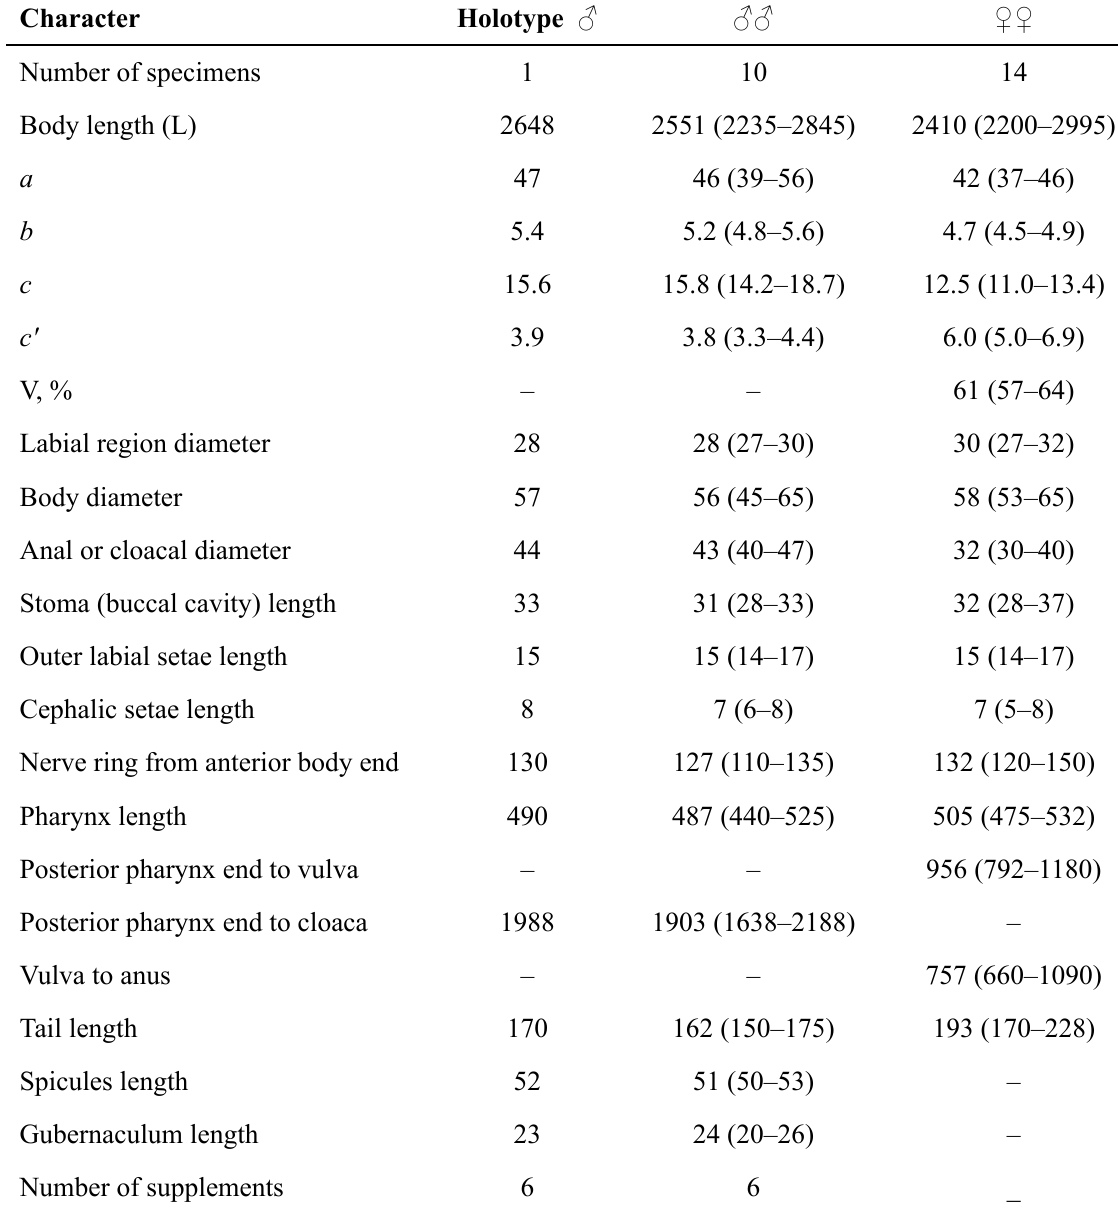
Table 1. Measurements (in µm) of Tobrilus elginus sp. nov., presented as mean and